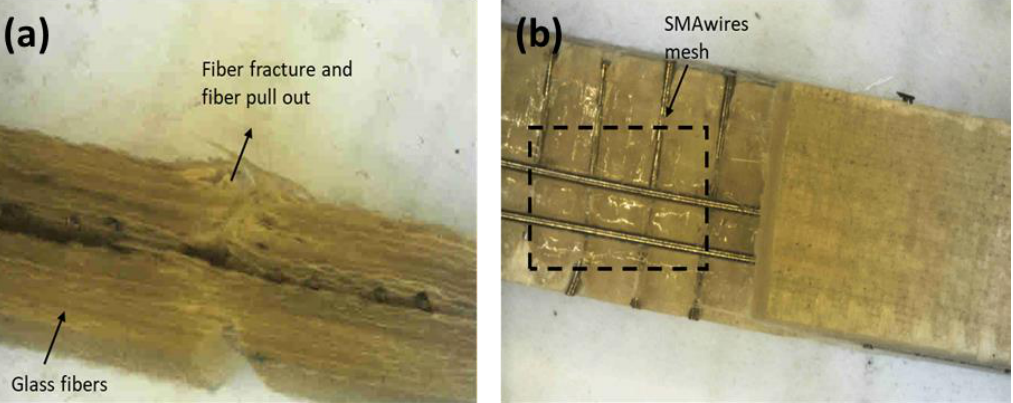
Figure 12. Set A: ( a ) cross-sectional view of SS/GFRP composite after impact; ( b ) top view of GFRP composite after impact.